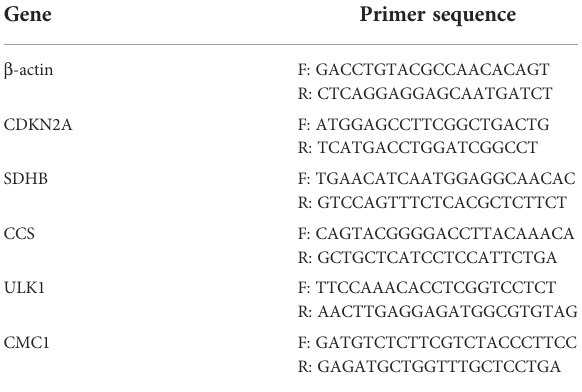
TABLE 1 Primer sequences of genes in the risk model used for qPCR. Gene Primer